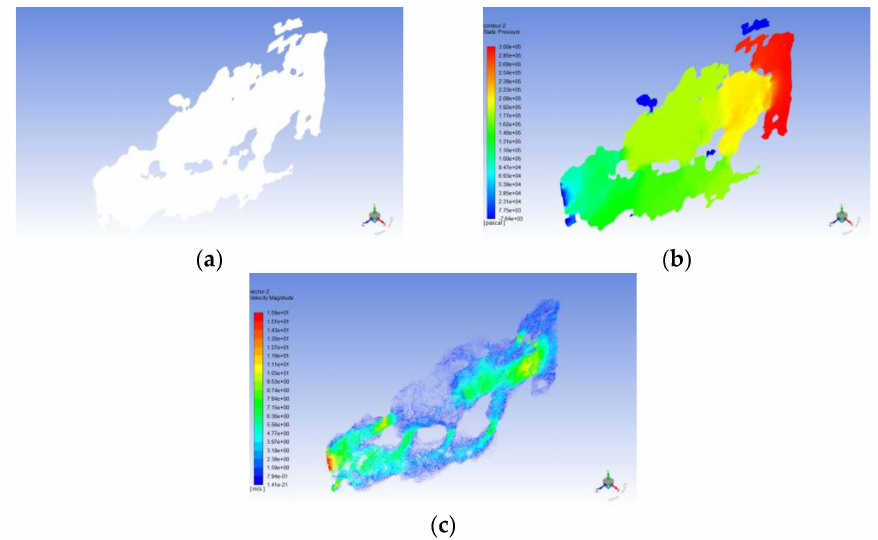
Figure 8. The 3 Mp pressure cloud and speed vector illustration: ( a ) fracture mesh model. ( b ) pressure cloud map. ( c ) speed vector illustration.